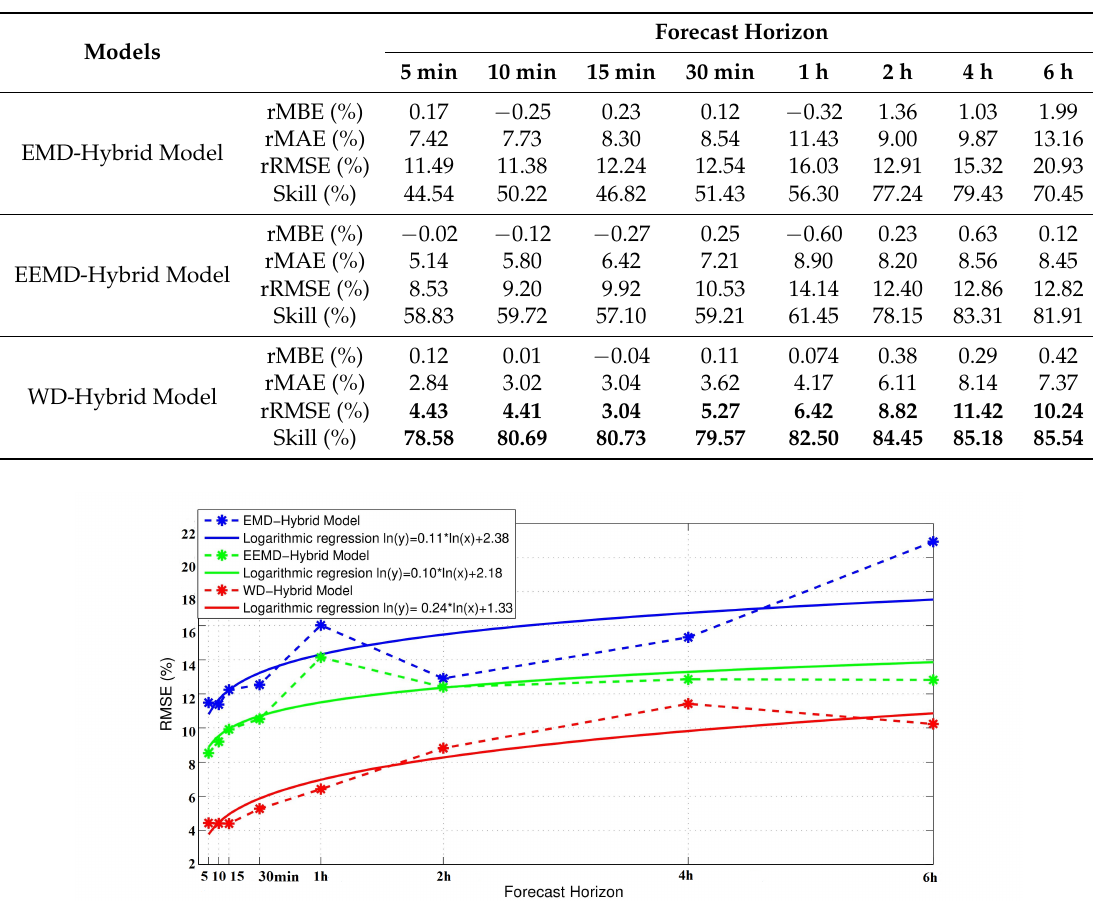
Table 1. The MHFM performances according to the forecasting horizon (Strategy 1).